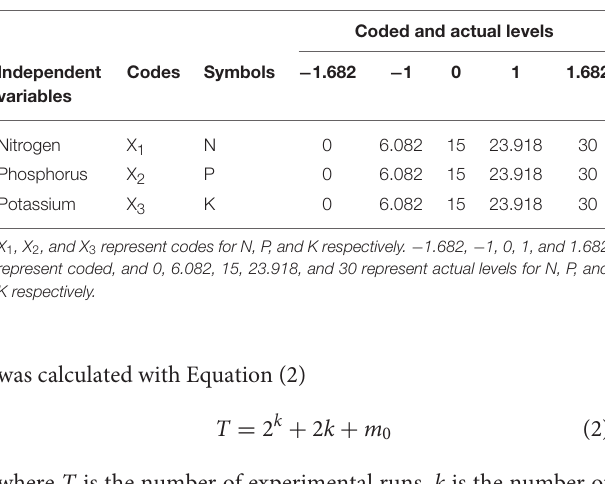
TABLE 1 | Independent variables, codes, and both their coded and actual values in the central composite rotatable design. Independent variables